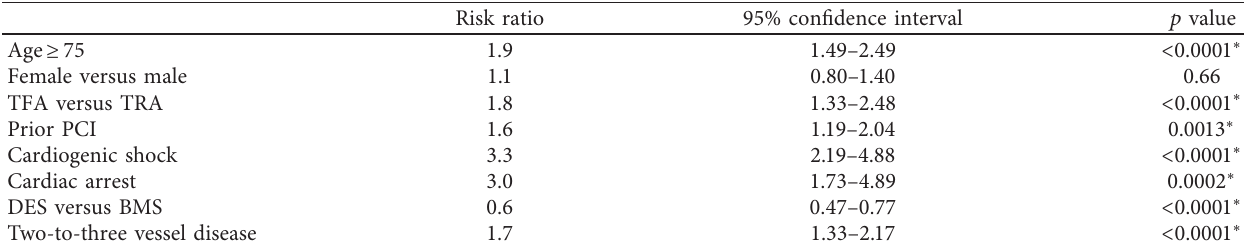
Table 4: Multivariate analysis of independent predictors of MACE at 12 months (Cox proportional hazard). Risk ratio